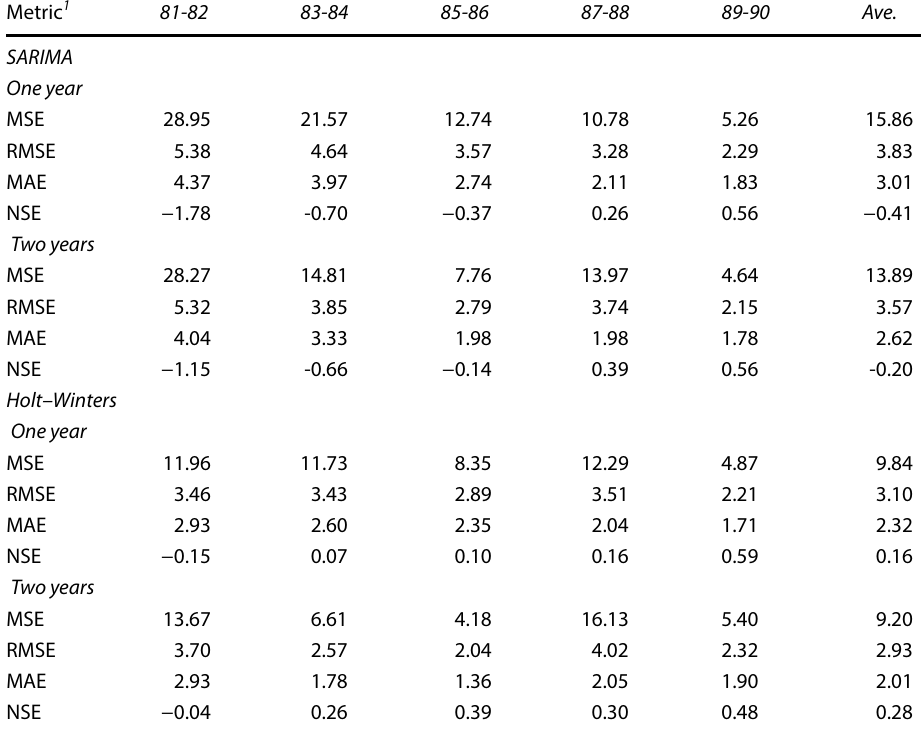
Table 1 SARIMA and HW forecasting errors on a rolling cross-validation scheme